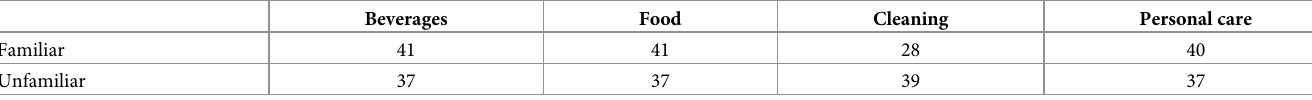
Table 1. Number of familiar and unfamiliar images selected for the pupillometry